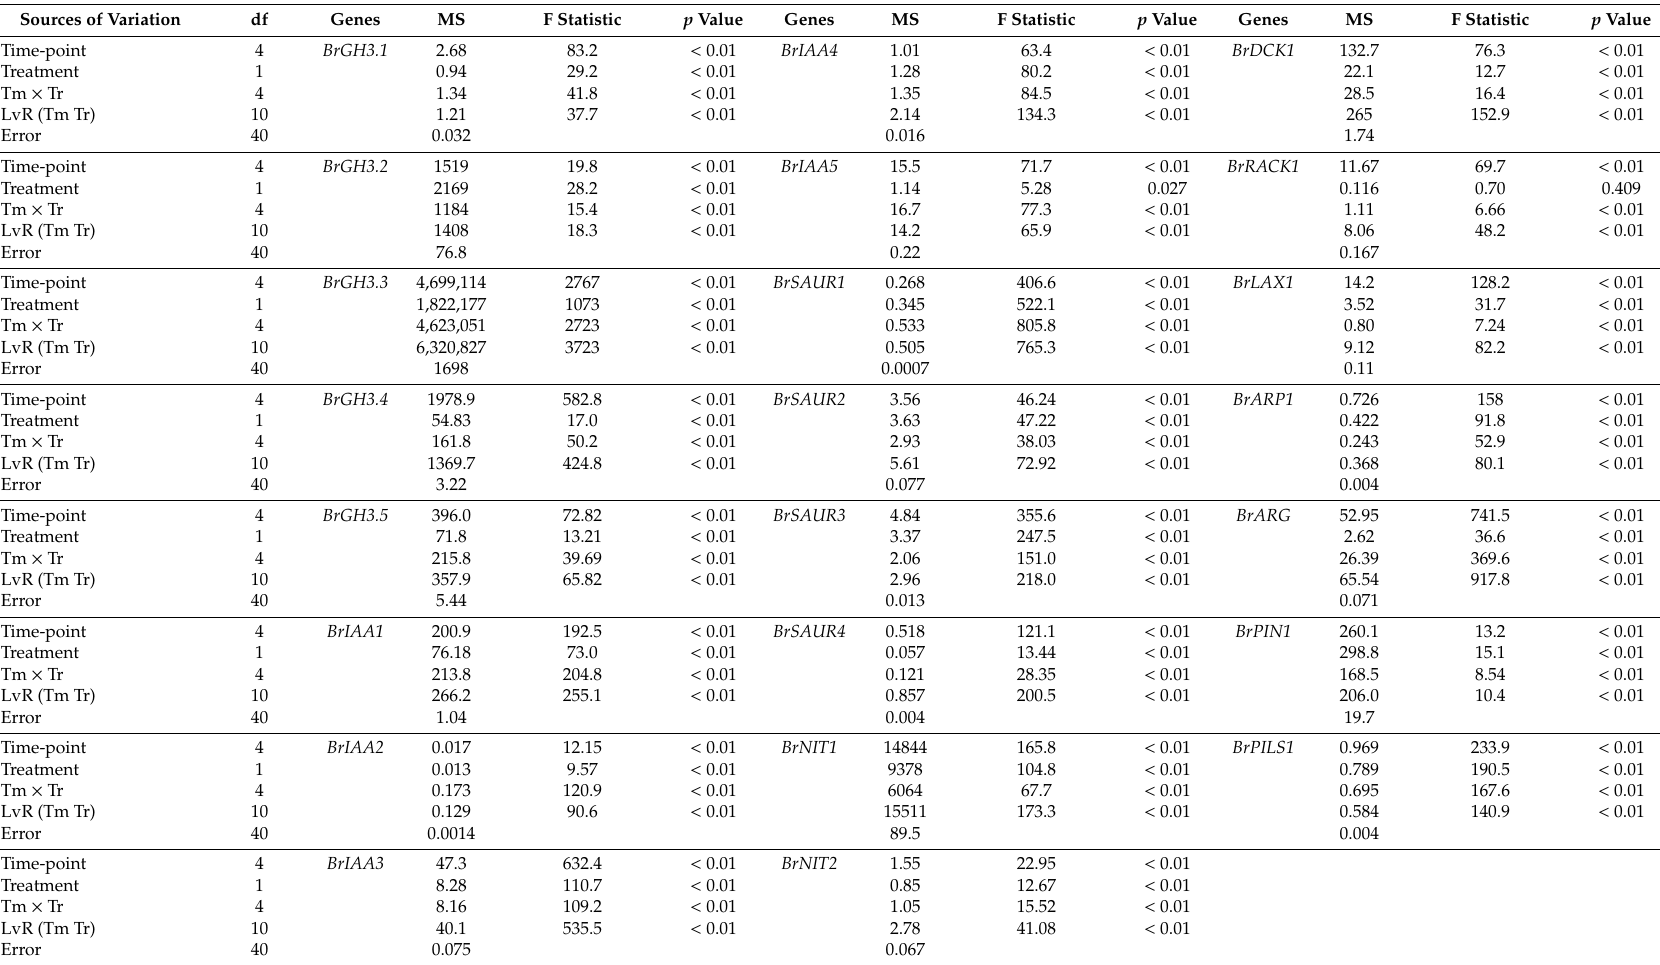
Table 2. Analysis of variance for relative expression levels of 23 auxin-biosynthesis related genes in two di ff erent sample types (leaf vs. root—LvR) at five di ff erent time-points (Tm) (1, 3, 14, 28, and 35 days after inoculation) under two di ff erent treatments (Tr, mock-treatment vs. inoculation with Seosan-isolate of P. brassicae ) in Chinese cabbage cultivar